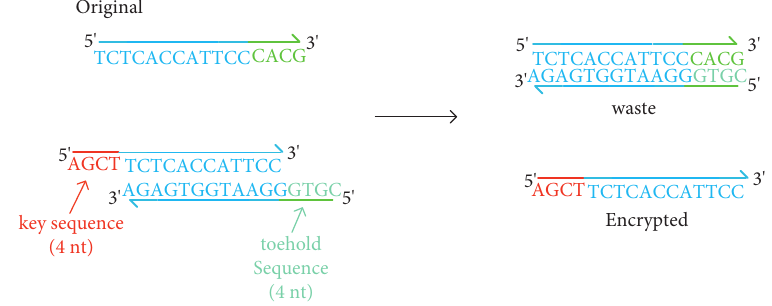
Figure 6: The DNA sequence encryption principle of DSD-rule b.